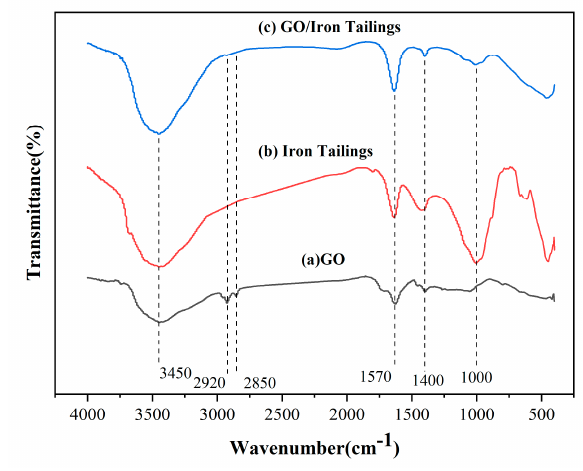
Figure 4. FT-IR of GO ( a ), iron tailings ( b ) and GO/iron tailings ( c ).